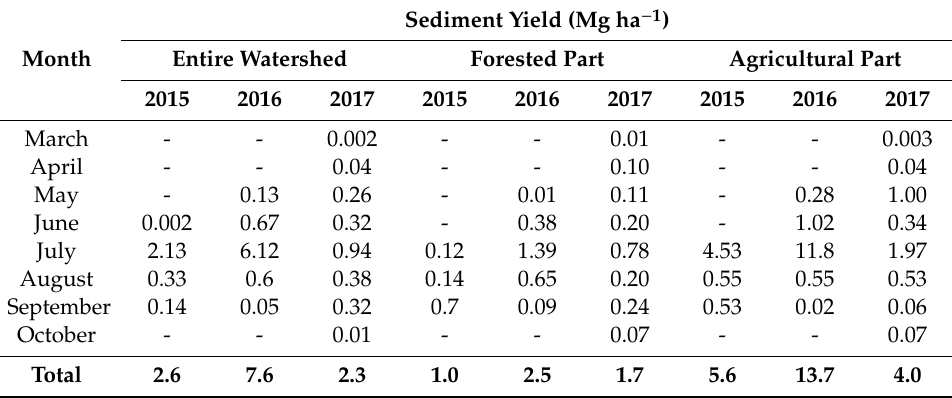
Table 4. Monthly sediment yields for forested, agricultural, and the entire Gomit watershed.